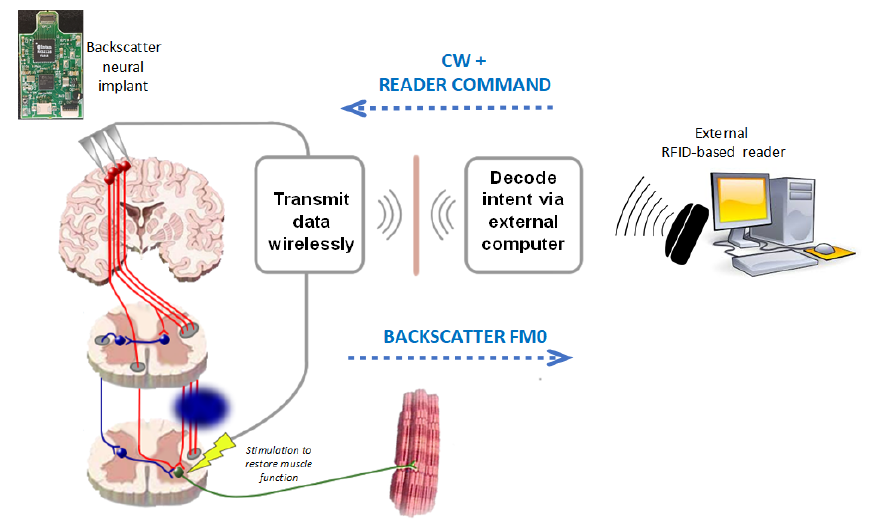
Figure 2. Communications scheme using a sensing RFID neural implant [33,34].